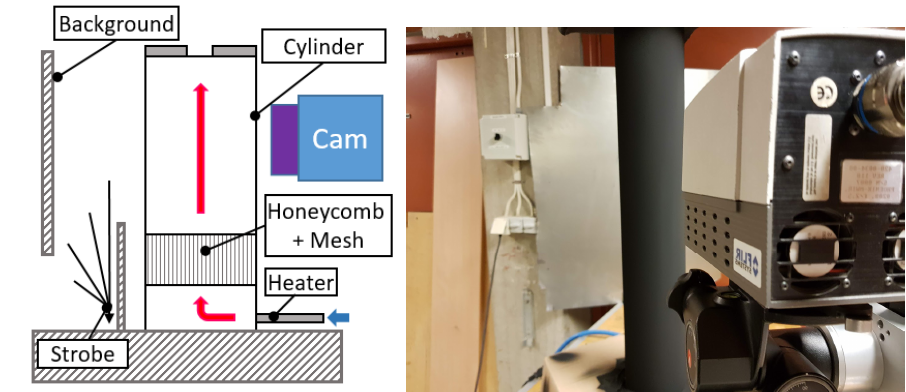
Figure 7. Emissivity calibration schematics ( left ) and photo of experimental set-up ( right